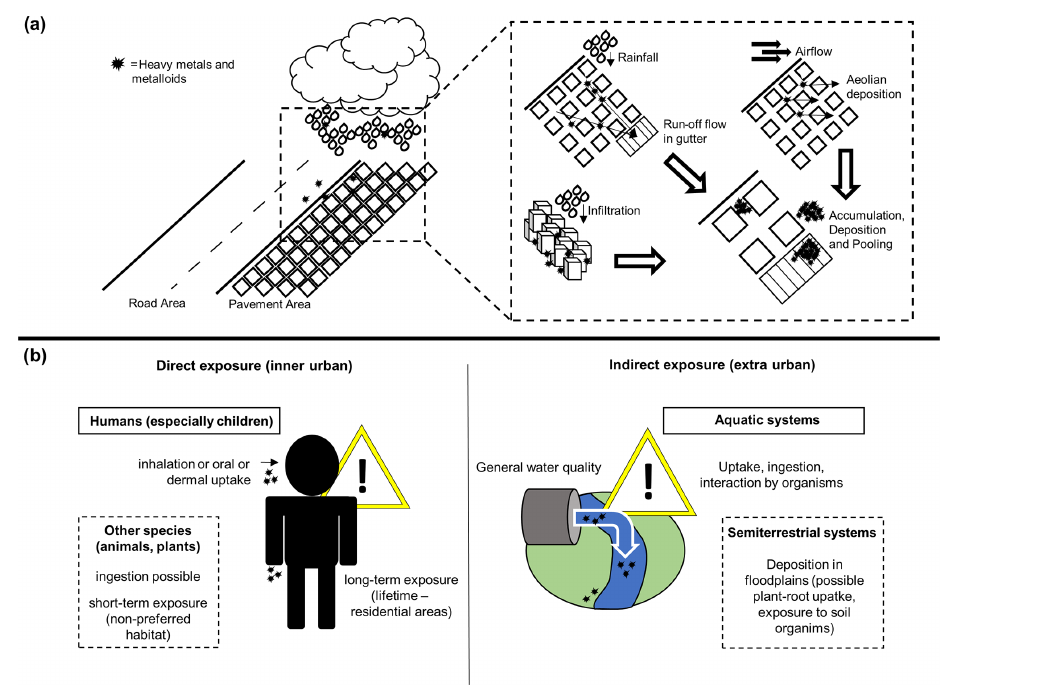
Figure 5. Risk assessment for heavy metal pollution in urban pavement joints. (a) Potential contamination pathways of heavy metals in urban pavement joints. (b) Potential risk exposures from heavy metals from urban pavement